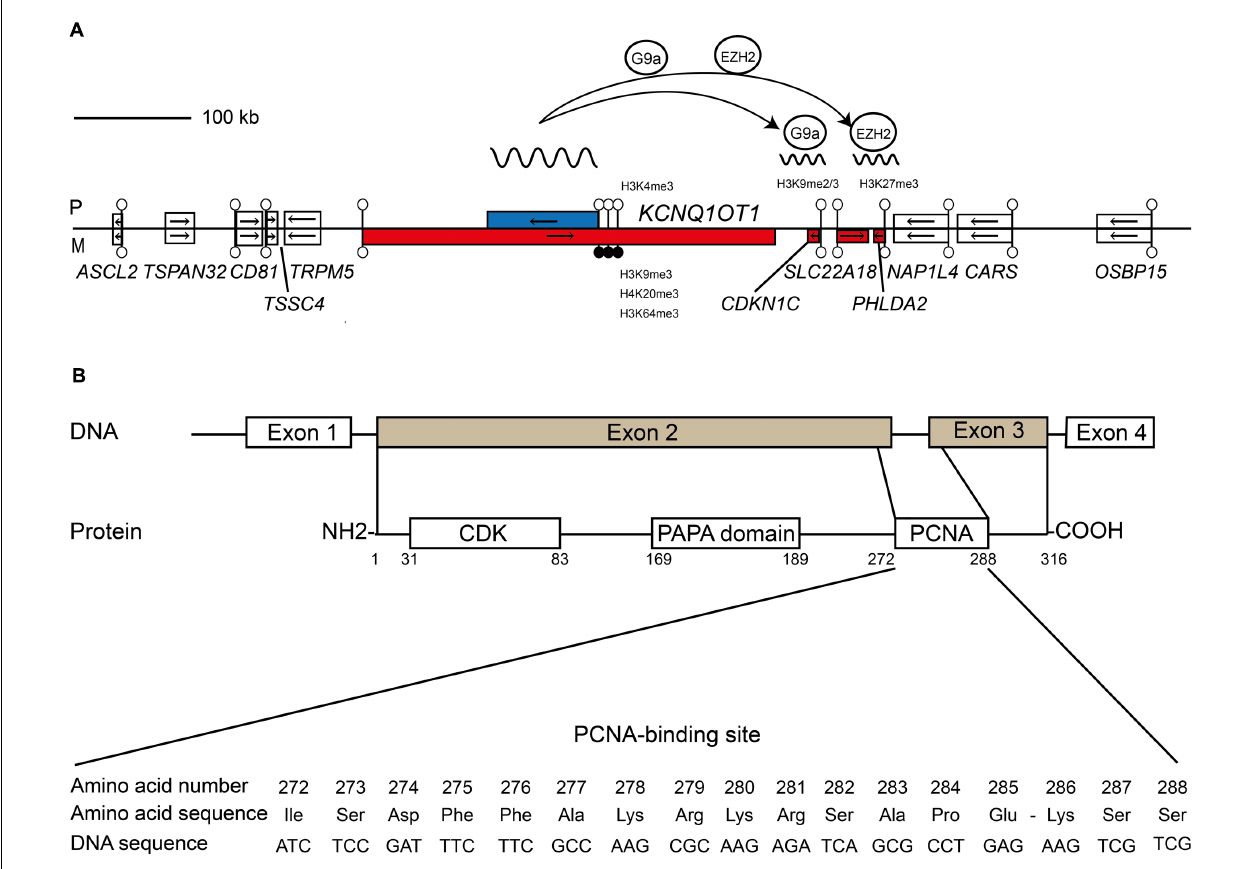
FIGURE 1 | Schematic representation shows the relative organization of genes, CpG islands and differentially methylated regions (DMRs) for KCNQ1OT1 - CDKN1C domain. (A) The centromeric imprinting domain on human chromosome 11p15.5 highlighting the role of the ncRNA KCNQ1OT1 in recruiting the G9a and EZH2 histone methyltransferase complexes to the paternal allele of CDKN1C . Open boxes depict non-imprinted genes. Blue boxes are paternally expressed genes; red boxes are maternally expressed genes, respectively. Lollipops signify CpG islands with open circles unmethylated and black circles methylated. The arrows show the direction of transcription. (B) Structural features and functional domains of the CDKN1C gene and protein. The CDKN1C possesses four exons with exons 2 and 3 encoding the functional protein. The protein has three key domains: a conserved amino-terminal containing the CDK inhibitory domains; the proline–alanine repeat (PAPA) domain; and the proliferating cell nuclear antigen (PCNA) domain which contains a nuclear localization signal. The nucleotide and amino acid sequence of the PCNA domain is